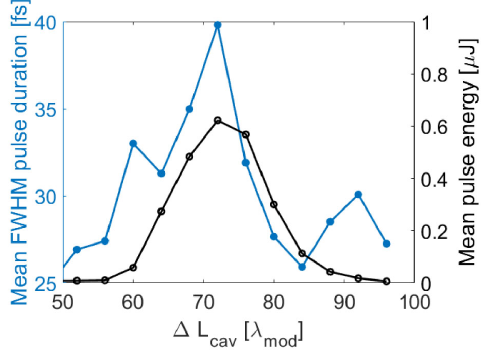
FIG. 8. Mean pulse duration (blue line) and pulse energy (black line) over 40 passes in the cavity for different cavity length detunings Δ L . The modulator in the cavity is tuned to cav λ ¼ 50 mod